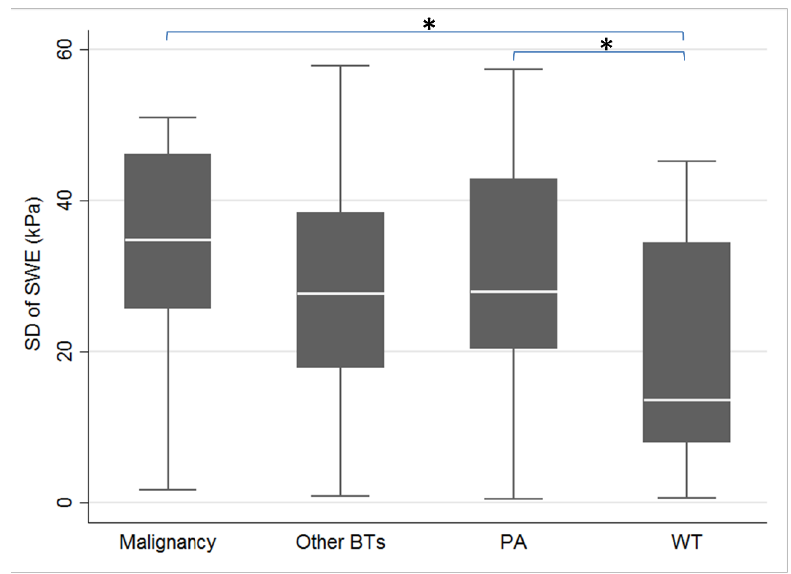
Figure 2. Comparison of the standard deviation of elasticity among different pathologies with Young’s modulus. Abbreviations: BT, benign tumor; PA, pleomorphic adenoma; SD, standard deviation; SWE, shear wave elastography; WT, Warthin’s tumor. Note. The standard deviation of elasticity of malignant tumors, pleomorphic adenoma, other benign tumors, and Warthin’s tumor showed significant differences under the Kruskal-Wallis test (median ± IQR, 34.8 ± 20.4, 28 ± 22.4, 27.7 ± 20.5, and 13.7 ± 26.4, p < 0.01). Comparisons within the group showed a significant difference between malignant tumor and Warthin’s tumor ( p < 0.01) and between pleomorphic adenoma and Warthin’s tumor ( p < 0.01), but no difference between malignant tumor and pleomorphic adenoma ( p = 0.21), between malignant tumor and other benign tumor ( p = 0.15), between pleomorphic adenoma and other benign tumor ( p = 0.62) and between Warthin’s tumor and other benign tumor ( p = 0.06). * Statistical significance, p < 0.05.